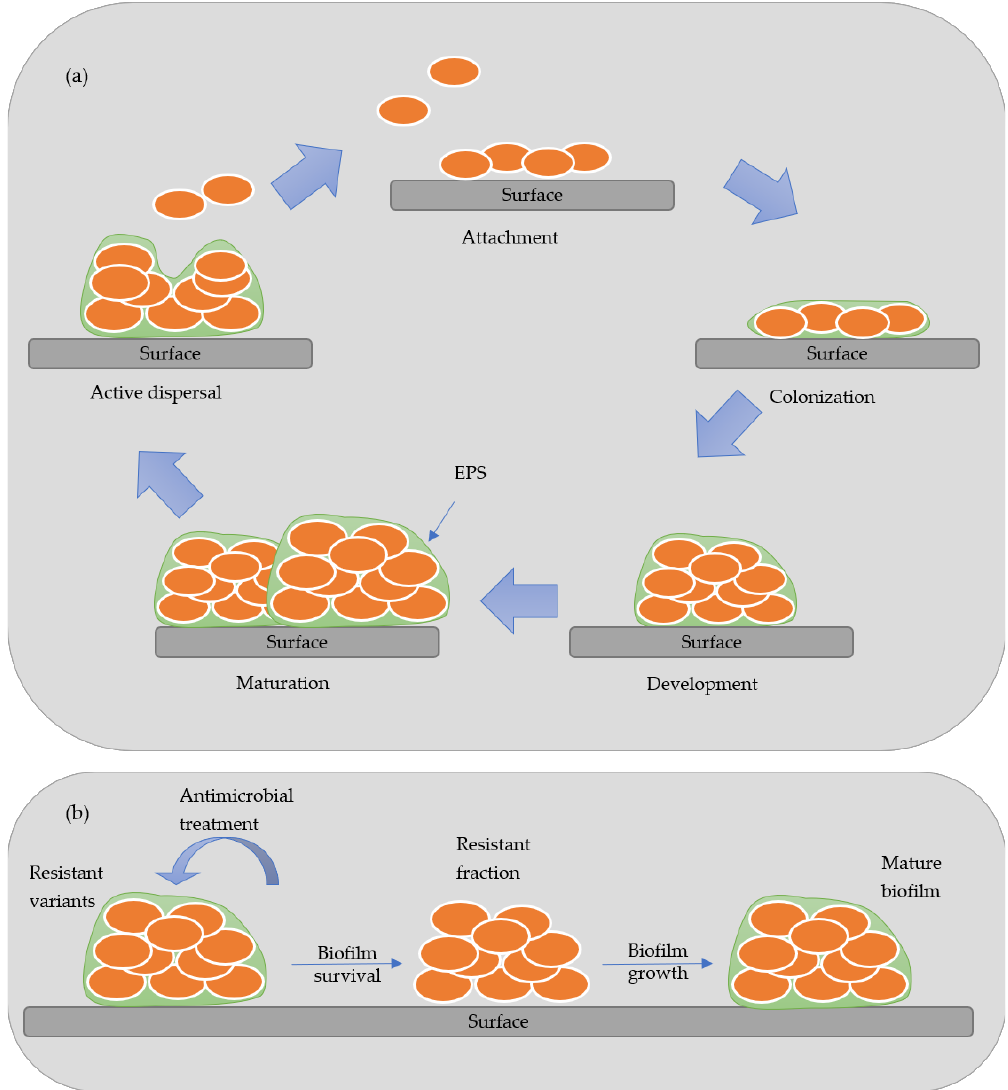
Figure 1. Model of biofilm formation ( a ) and antimicrobial resistant variants ( b ). The main mechanisms of antimicrobial action by which antimicrobial compounds affect microorganism are protein synthesis inhibition, cell wall disruption, and nucleic acid inhibition. Antimicrobial compounds can act as suppressing protein synthesis targeting the ribosomal subunits or protein folding, thus inhibiting their active role. They can also disrupt cell walls, causing an increase of permeability of the membrane, leading to the leakage of intracellular constituents. In addition, they are able to inhibit nucleic acid mechanism by suppressing the replication of deoxyribonucleic acid (DNA) and ribonucleic acid (RNA) [8]. Currently, there is no deep knowledge on the mechanism of action against pathogenic microorganisms and the way they will act on